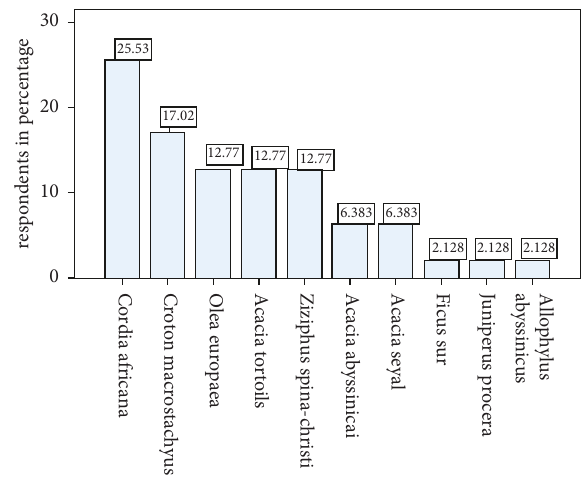
Figure 3: List of common woody species that existed before (15-20 years ago). Table 7: Productive role of Acacia seyal